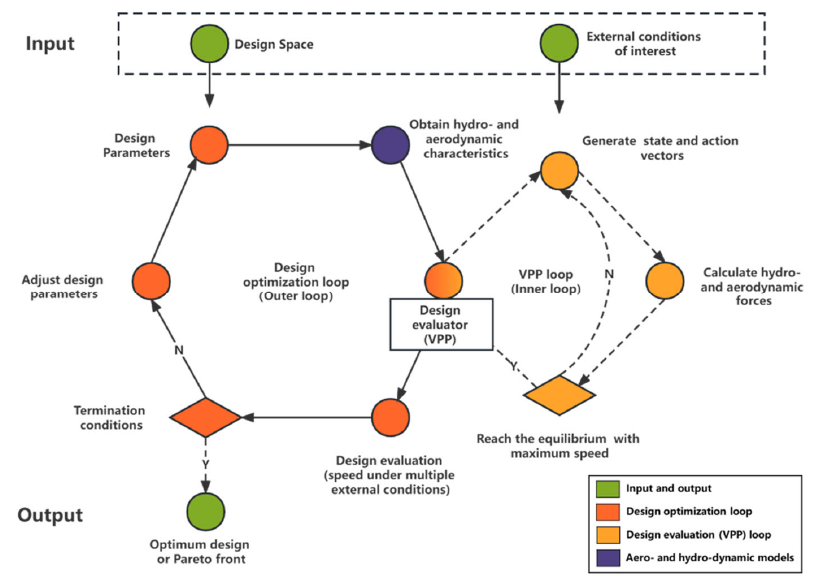
Figure 1. General configuration optimisation framework for a typical sailboat . Note: the same colours will be used in later flowcharts to aid better understanding.